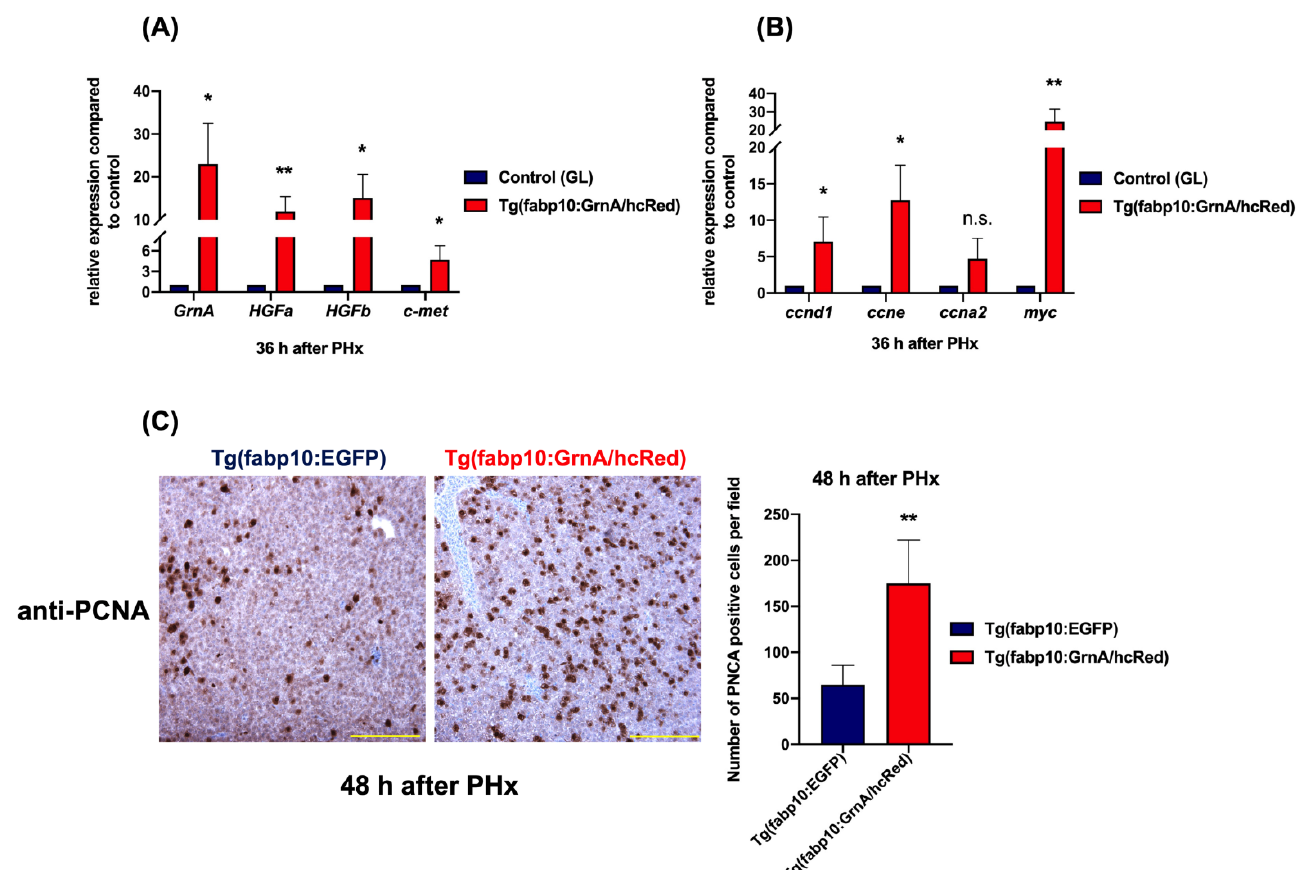
Figure 6. Liver-specific overexpression of GrnA positively regulated the HGF/c-met axis in hepatectomized zebrafish. ( A ) Quantitative PCR analysis of zebrafish GrnA , HGFa , HGFb , and c-met in hepatectomized zebrafish at 36 h after PHx. ( B ) The cell cycle regulatory genes ( ccnd1 , ccne , and ccna2 ) and cell proliferation-associated gene, myc , were examined by quantitative PCR. The relative expression levels compared to control group are presented as mean ± SD. EF1a served as the internal control. ( C ) Immunohistochemistry staining of PCNA in liver ventral lobe at 48 h after PHx. Scale bar: 50 μ m. Number of PCNA-positive cells was quantified using ImageJ. The data are presented as mean ± SD. Significance was set at * p < 0.05, ** p < 0.01, as determined by t -test; PHx, partial hepatectomy; GL, green liver transgenic line.